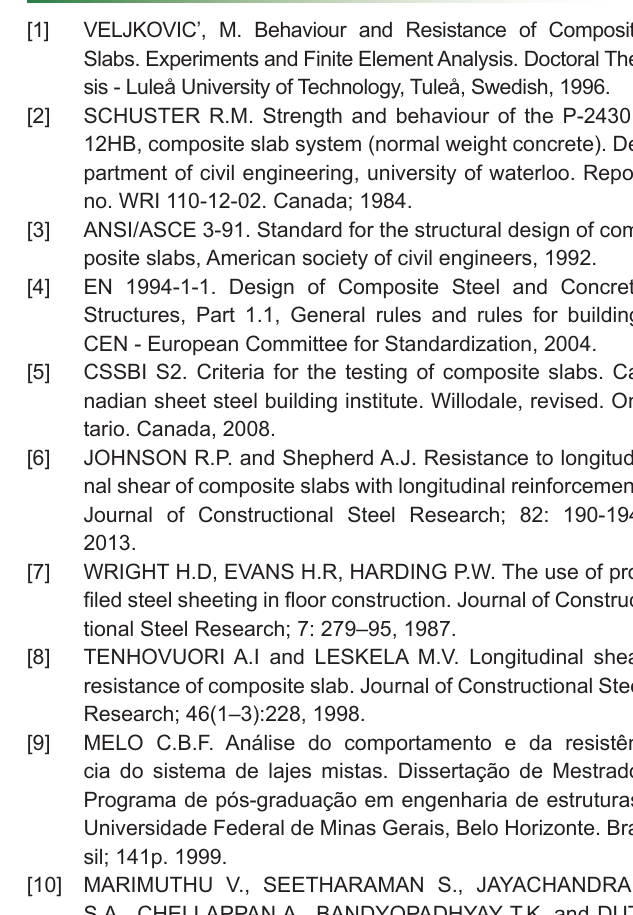
Figure 19 Curves of nominal resistance moment, M and of applied nominal bending moment, M for the verification of the longitudinal shear resistance of two concentrated